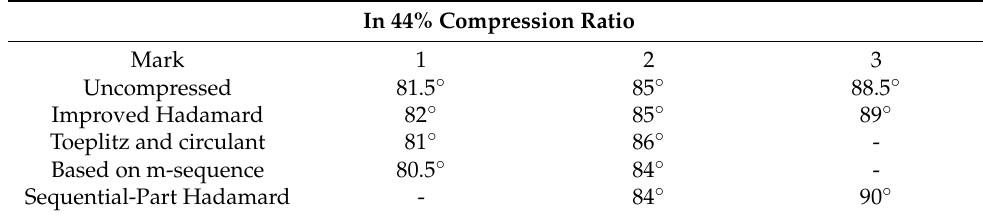
Table 4. The angle of a mark in 44% Compression Ratio.